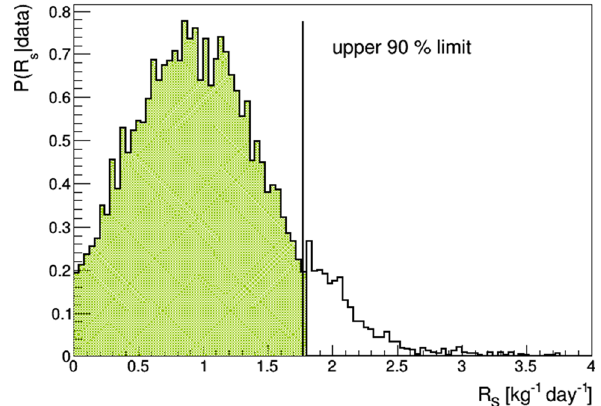
Fig. 7 Marginalized posterior PDF for the signal rate R S . For this example with a fixed peak position of 0.4keV the upper 90% limit is